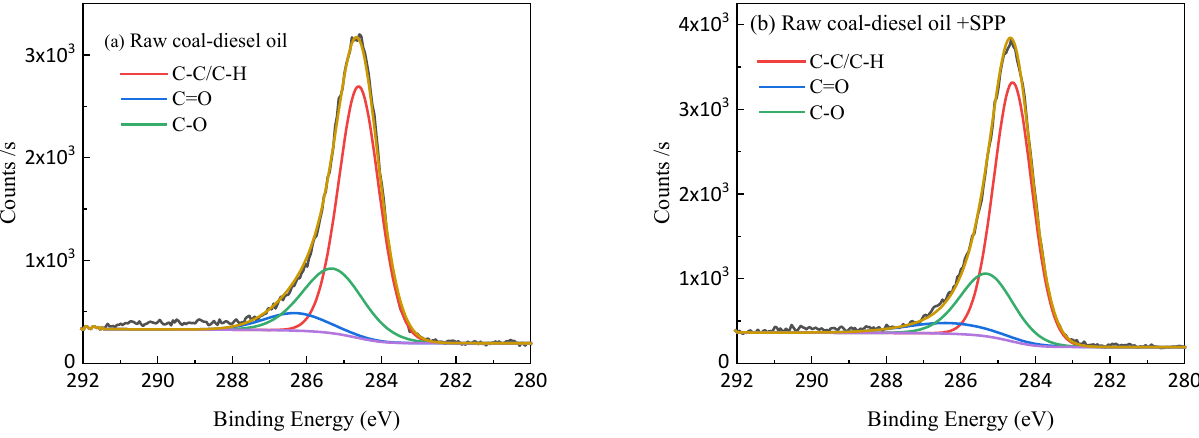
Figure 8. Fitting of the C1s peaks of coal samples with different conditions: ( a ) coal was treated with diesel oil; ( b ) coal was treated with diesel oil and SPP. Table 4. Relative elemental atomic concentrations of coal samples with different samples.